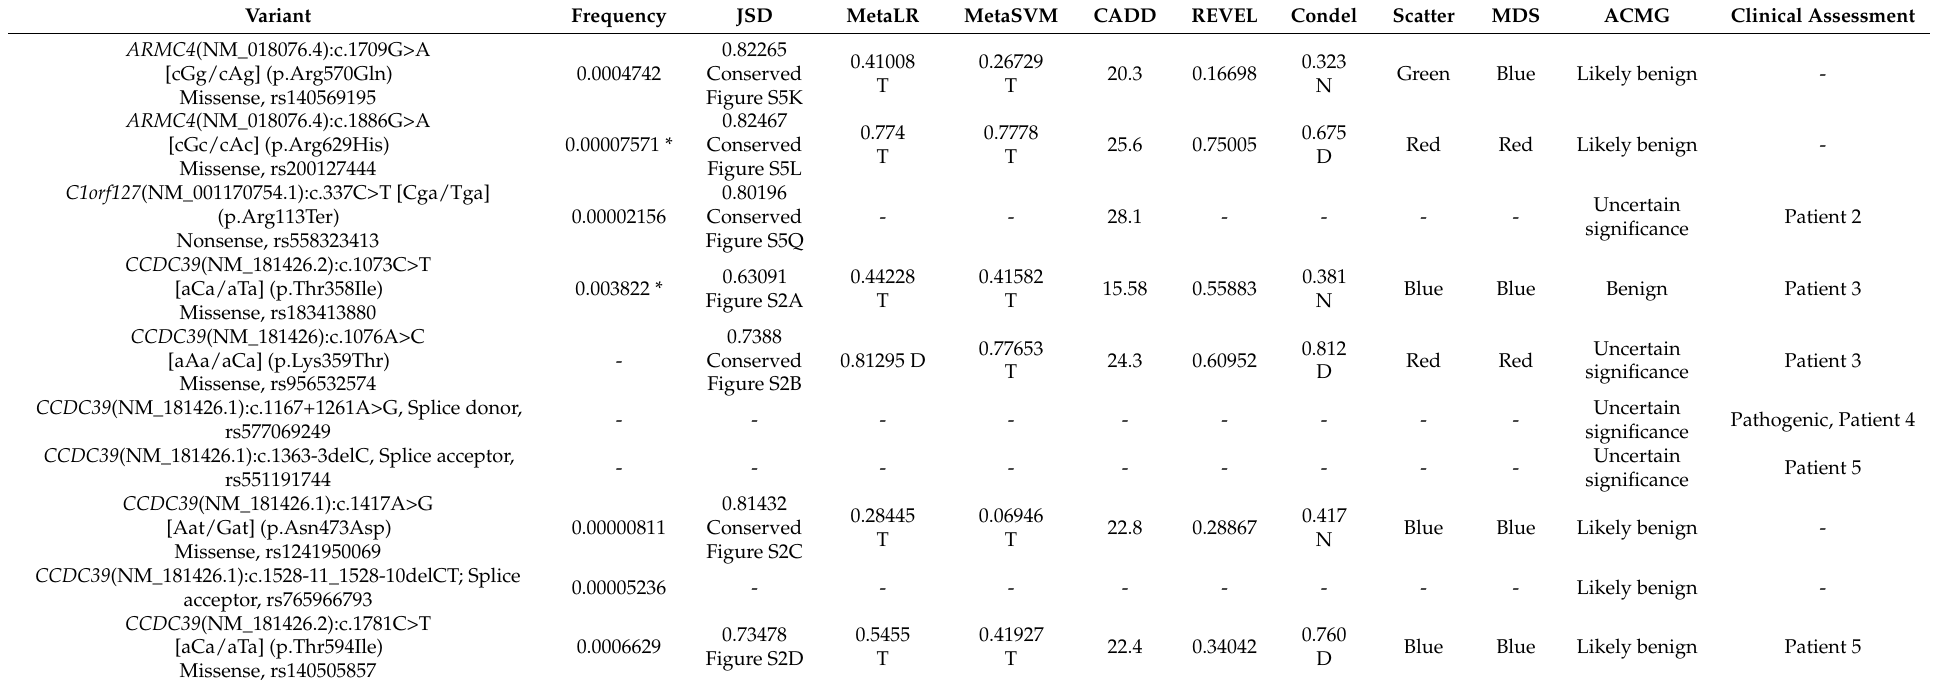
Table 2. Studied variants of PCD. Exome allele frequency is from gnomAD; * indicates if homozygotes have been reported. JSD (Jensen–Shannon Divergence) scores range from 0 to 1.0, with higher values indicating better conservation; ‘Conserved’ refers to complete conservation of the amino acid at the site over the 10 studied species (see Methods) and ‘figure numbers’ to the multiple sequence alignment. MetaLR ( meta -analytic logistic regression that integrates variant pathogenicity scores and allele frequency to predict deleteriousness) ranked scores range from 0 to 1; higher scores are a more likelihood of pathogenicity. MetaSVM ( meta -analytic support vector machine that integrates multiple omics data) ranked scores range from 0 to 1; higher scores are a more likelihood of pathogenicity. CADD (combined annotation-dependent depletion) refers to PHRED-scaled CADD scores that range from 1 to 99 (e.g., a score of 30 suggests the variant is top 0.1%). REVEL (rare exome variant ensemble learner that integrates data from several pathogenicity predictor software) ranked scores range from 0 to 1; higher scores are a more likelihood of pathogenicity. Condel (consensus deleterious generated from SIFT (made from sequence homology and biochemistry of the alternate residue) and PolyPhen2 (made from sequence homology and known database of the protein secondary structure)) scores range from 0.0 (tolerated) to 1.0 (deleterious). ‘Scatter’ refers to k-means clusters in the scatter plot of REVEL versus Condel scores (see Figure 1C) and ‘MDS’ refers to k-means clusters in the MDS plot of MetaLR, MetaSVM, CADD, REVEL, and Condel scores (see Figure 1A); red indicates possibly pathogenic, blue uncertain, and green possibly benign. American College of Medical Genetics and Genomics (ACMG) classification was from https://www.varsome.com (Accessed on 29 November 2020). Clinical assessment is for variants with supportive functional evidence. Patient phenotypes are summarized in Table 3. D, deleterious; T, tolerated; N,